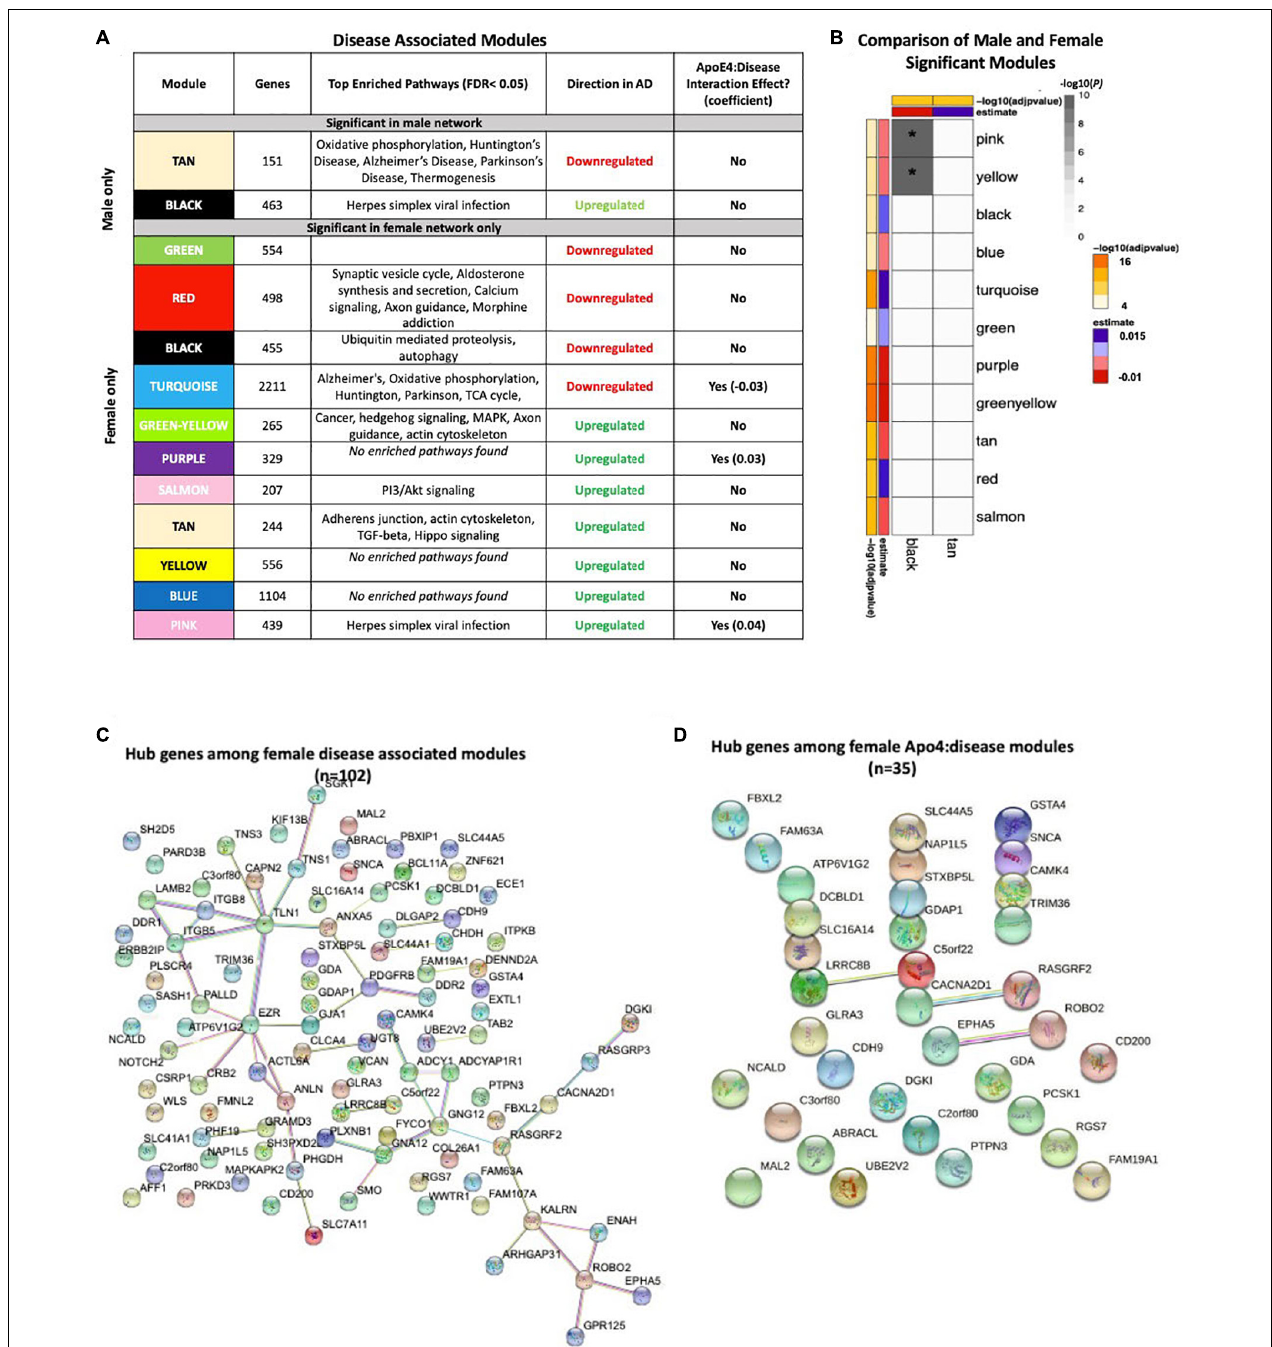
FIGURE 3 | Network analysis in the brain. WGCNA was used to construct gene network separately for males and females in the brain. Networks were randomly assigned colors. (A) A description of the disease-associated gene networks (termed modules) produced using WGCNA. Significant disease-associated modules were identified by associating module eigengene to case/control status adjusting for age and APOE ε 4 status ( P < 0.05). KEGG enrichment analysis of significant was conducted using an adjusted P- value threshold of 0.05. The direction in AD is computed using the case/control coefficient of the model associating module eigengene to case/control status. Modules with significant APOE ε 4 :disease interaction effect were identified by adding the interaction term APOE ε 4 :disease to the previous model ( P < 0.05). (B) Heatmap depicting the degree of module overlap assessed using a hypergeometric test between male and female disease-associated modules. The black module in males had significant overlap ( P < 0.05) with the pink and yellow modules, indicated by * in the heatmap. Estimate and − log10(adjpvalue) refers to the case/control coefficient and p -value in the model: module eigengene ∼ age + APOE ε 4 + case/control status. (C) Hub genes from female disease-associated modules. Hub genes were defined as genes with gene significance (the correlation between the gene expression and